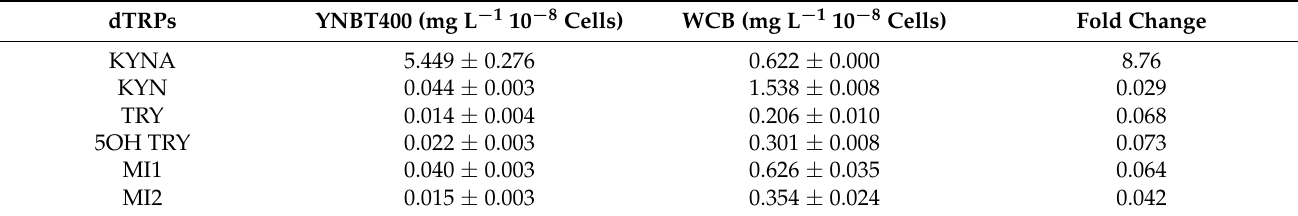
Table 2. Comparison of the production of dTRPs in fermentations in YNBT400 medium and in WCB experiments at 24 h. The productions were normalized against the yeast biomass and expressed as mg L − 1 10 − 8 cells. The fold change of the main dTRPs was calculated as the ratio between the concentration of the corresponding metabolite in the two investigated